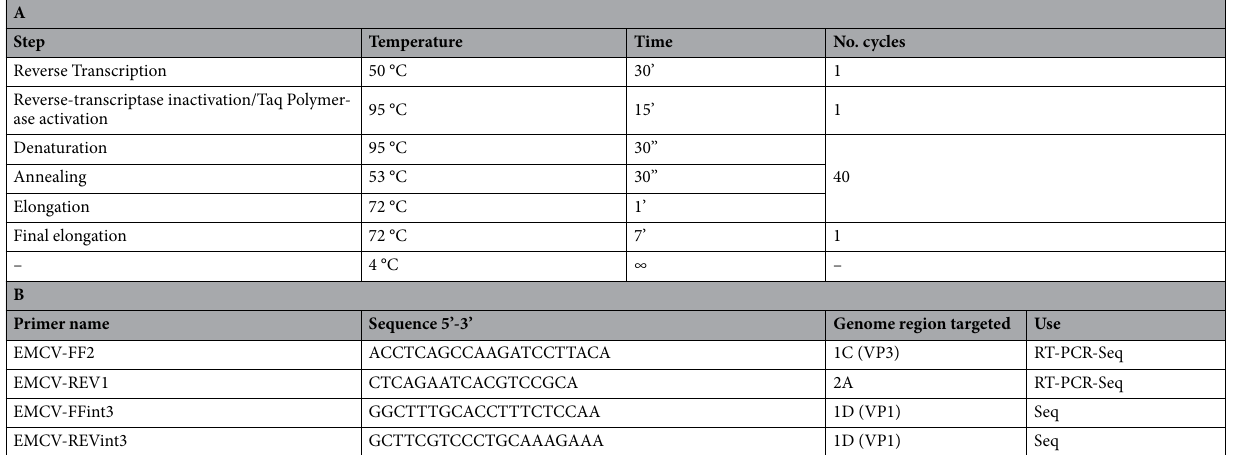
Table 1. Specifics of RT-PCR VP1 targeted. Tables show technical specifics of RT-PCR reaction used for amplification of 1D gene (coding for VP1) of EMC virus. A, thermal profile of RT-PCR, including temperature, duration and repeats of each step. B, primer used for amplification of 1D and for Sanger